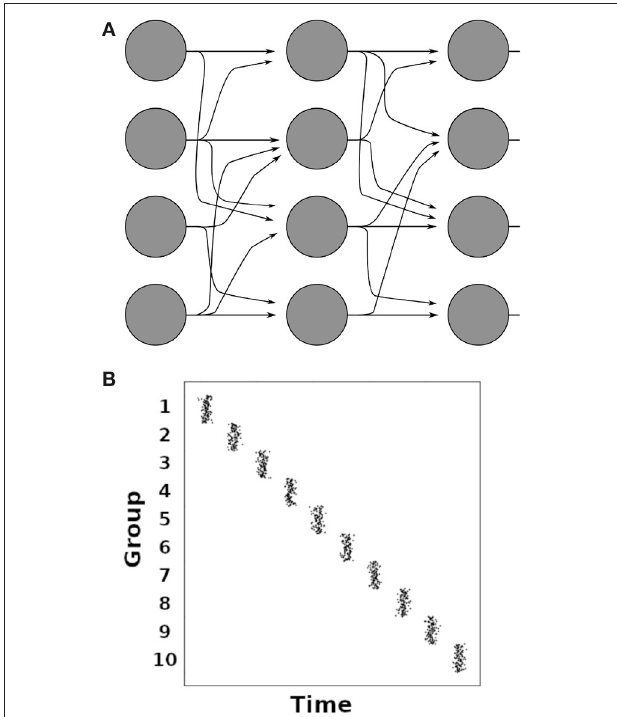
FIGURE 4 | (A) Illustration of a synfire chain between groups of neurons (filled circles). Arrows indicate excitatory connections. (B) Illustration of a spiking histogram of neurons in a synfire chain with 10 groups of 100 neurons each. The average time interval between the firing of two adjacent groups corresponds to one synaptic